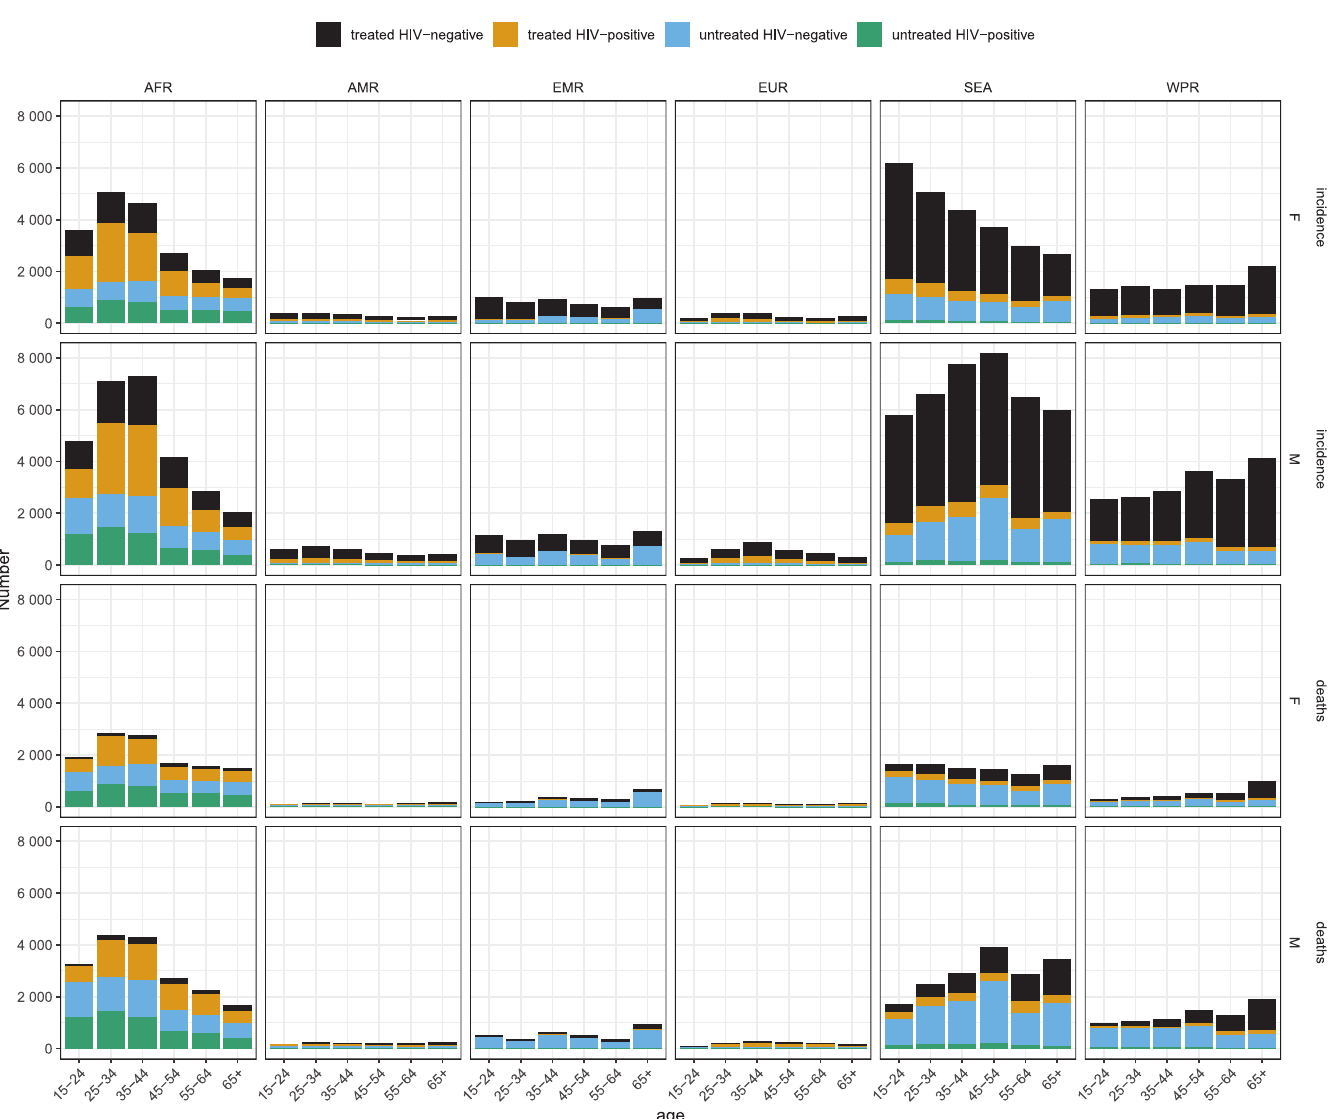
Fig 3. TBM incidence and deaths sex, age, WHO region, HIV-infection and anti-tuberculosis treatment status. TBM: tuberculous meningitis; AFR: African Region; AMR: Americas Region; EMR: Eastern Mediterranean Region; EUR: European Region: SEA: South East Asian Region: WPR: Western Pacific Region; WHO: World Health Organization; F: female; M: